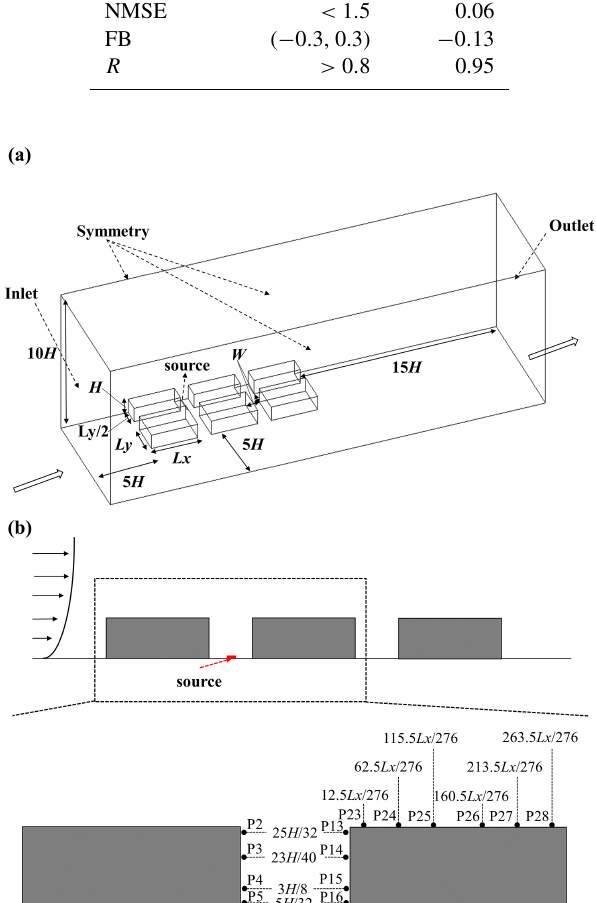
Figure 9. (a) The simulation domain of 3D pollutant dispersion and (b) the measurement points’ locations in the street canyon.